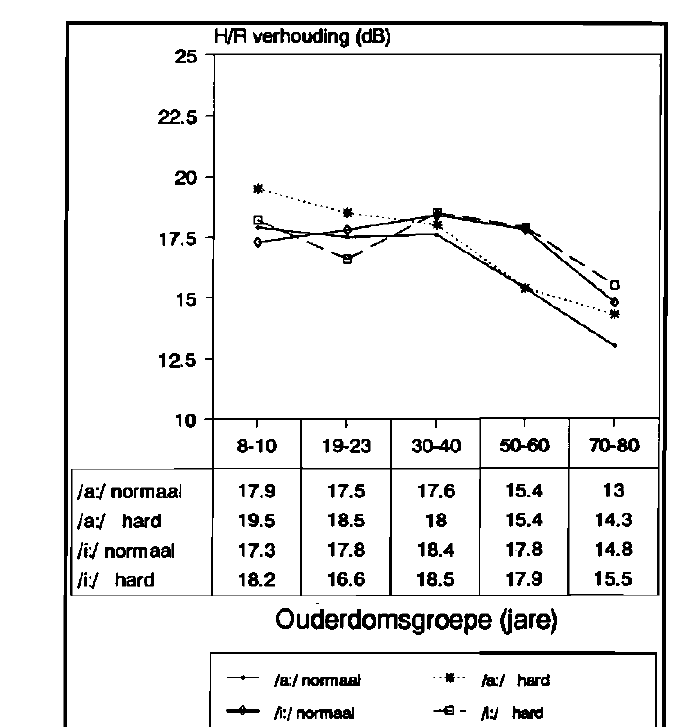
skatting te maak van die onbekende populasie-